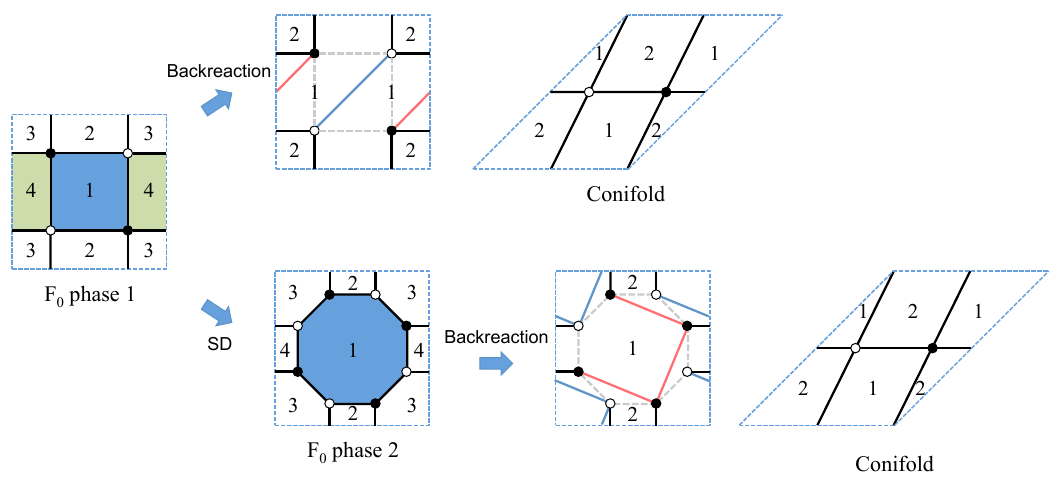
Figure 42. Starting from phase 1 of F 0 , we compare the backreaction of an instanton on face 1 before and after Seiberg duality on the adjacent face 4.